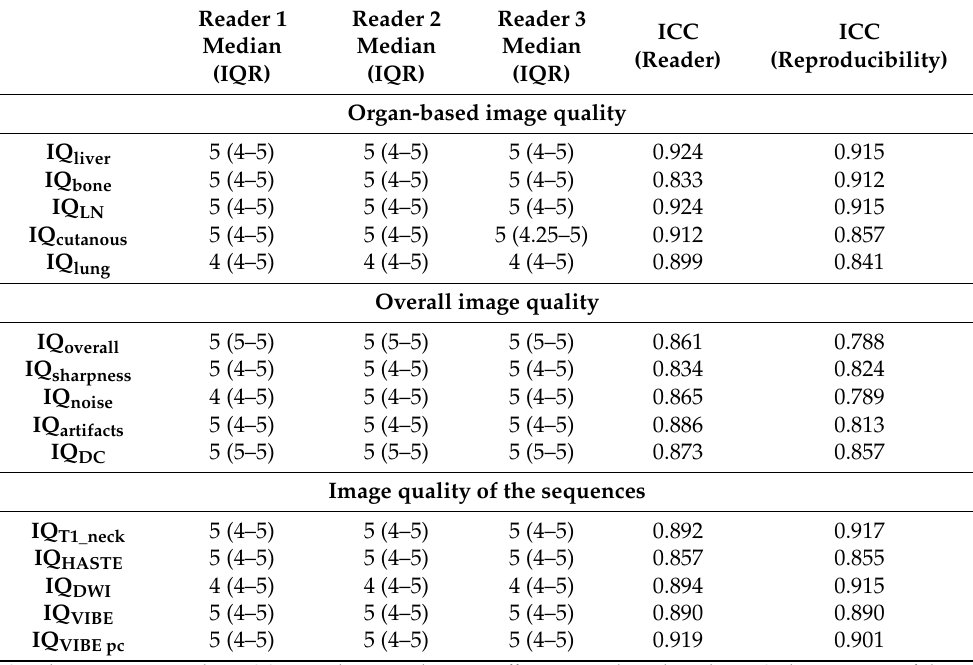
Table 3. Image Quality, interreader Agreement and